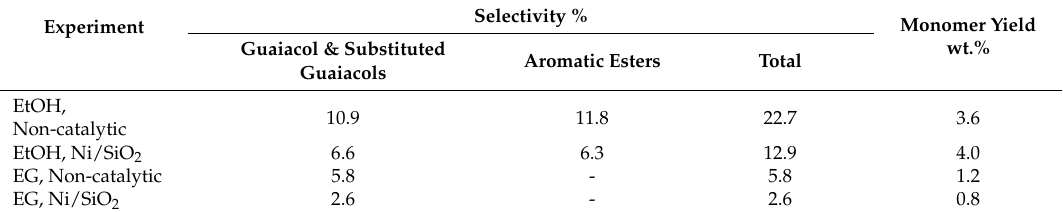
Table 4. The selectivity of monomers in the oil fractions from non-catalytic and catalytic conversion of H-LS, and the total monomer yields. Reaction condition: 0/0.75 g catalyst, 7.5 g H-LS, 75 mL